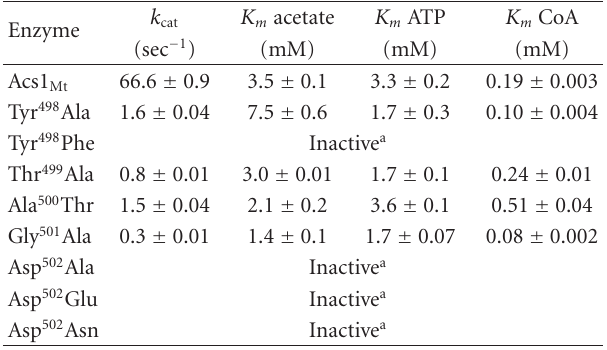
Table 2: Kinetic parameters for ACS1 Mt wild-type and variant